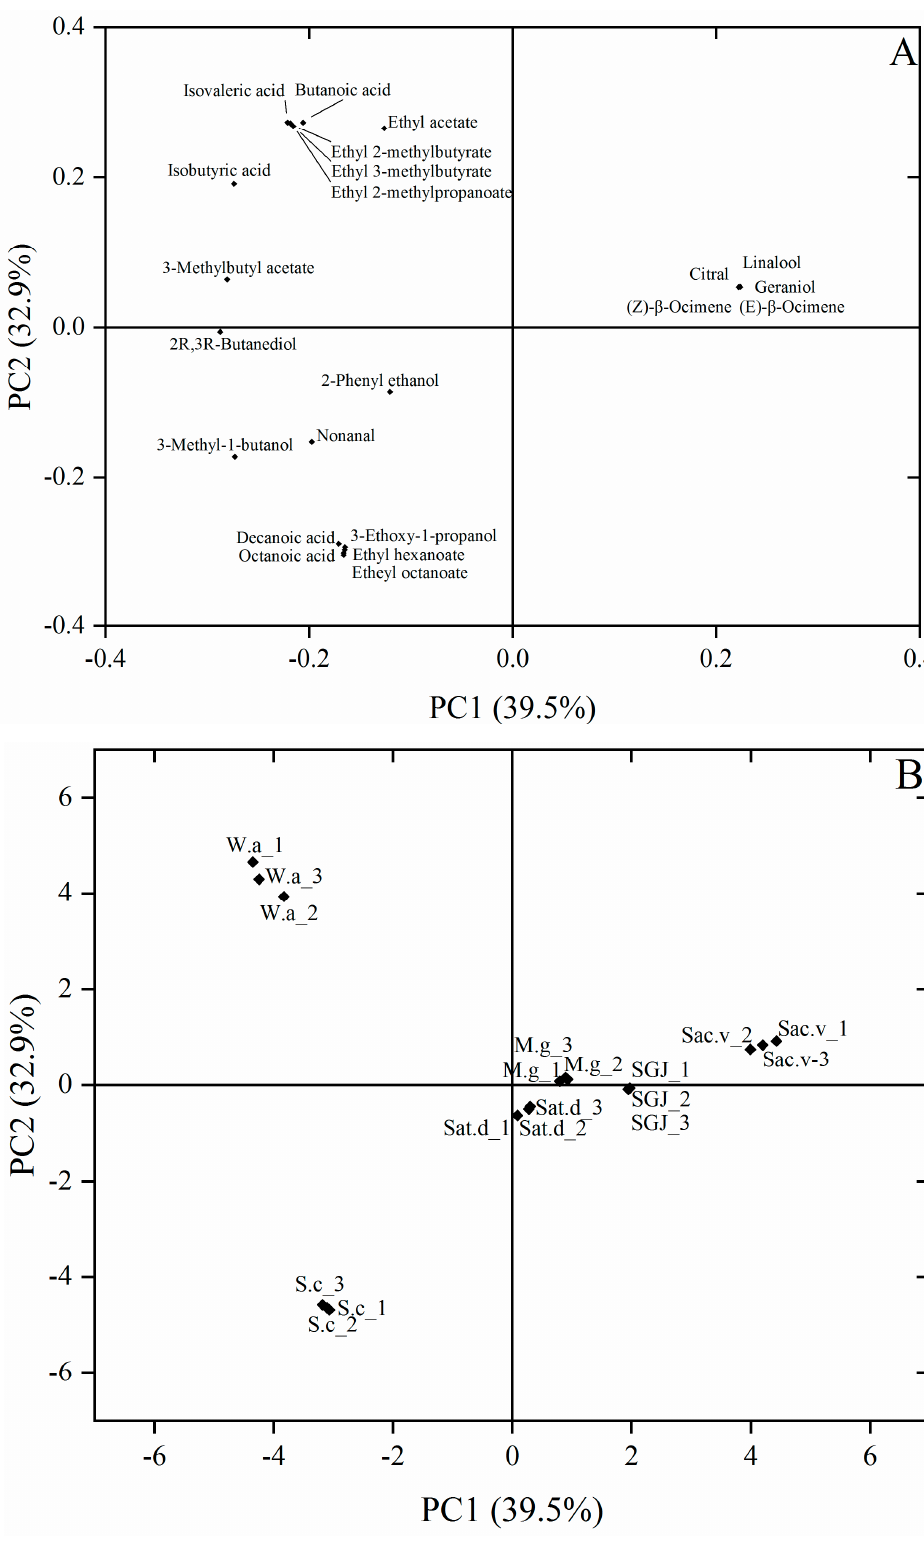
Figure 2. PCA analysis of key aroma compounds ( A ) and the distribution of five fermented media and SGJ ( B ) based on the first two principal components. M. g = M. guilliermondii (AD-58), Sat. d = Sat. diversa (BZL-11), Sac. v = Sac. vini (BZL-28), W. a = W. anomalus (DR-110), S. c = S. cerevisiae (EC1118), SGJ = Synthetic grape juice (uninoculated).